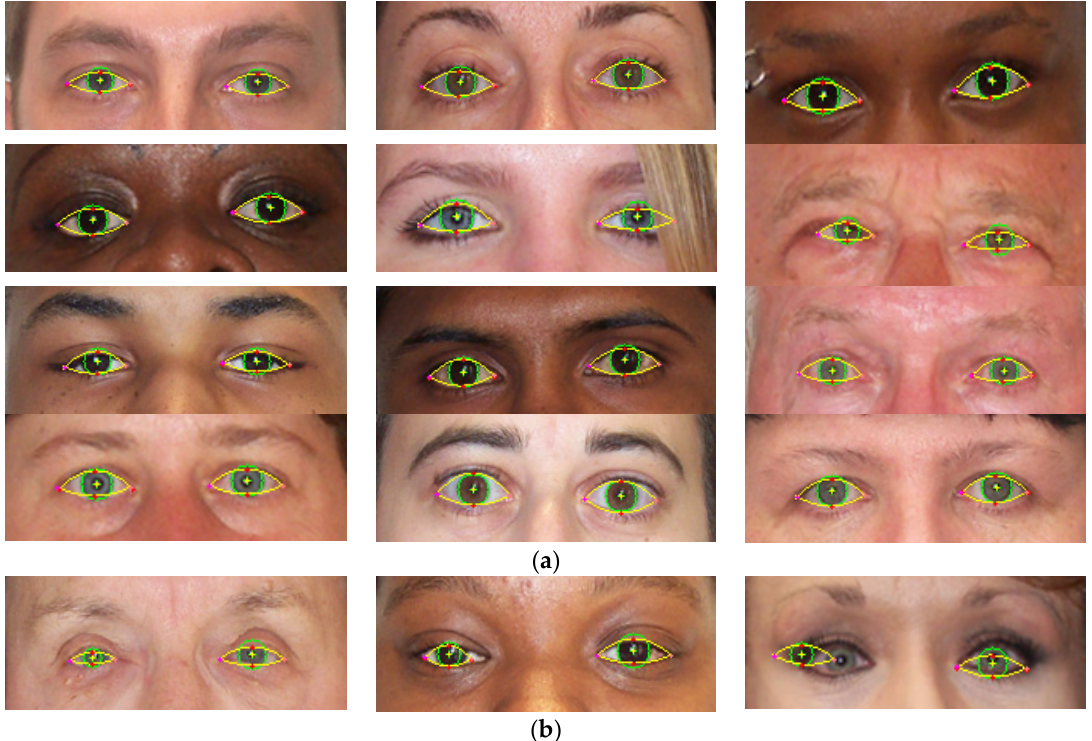
Figure 18. Eye shape segmentation results on University of Michigan Face Database. ( a ) Eye shape extraction results; and ( b ) failure cases.